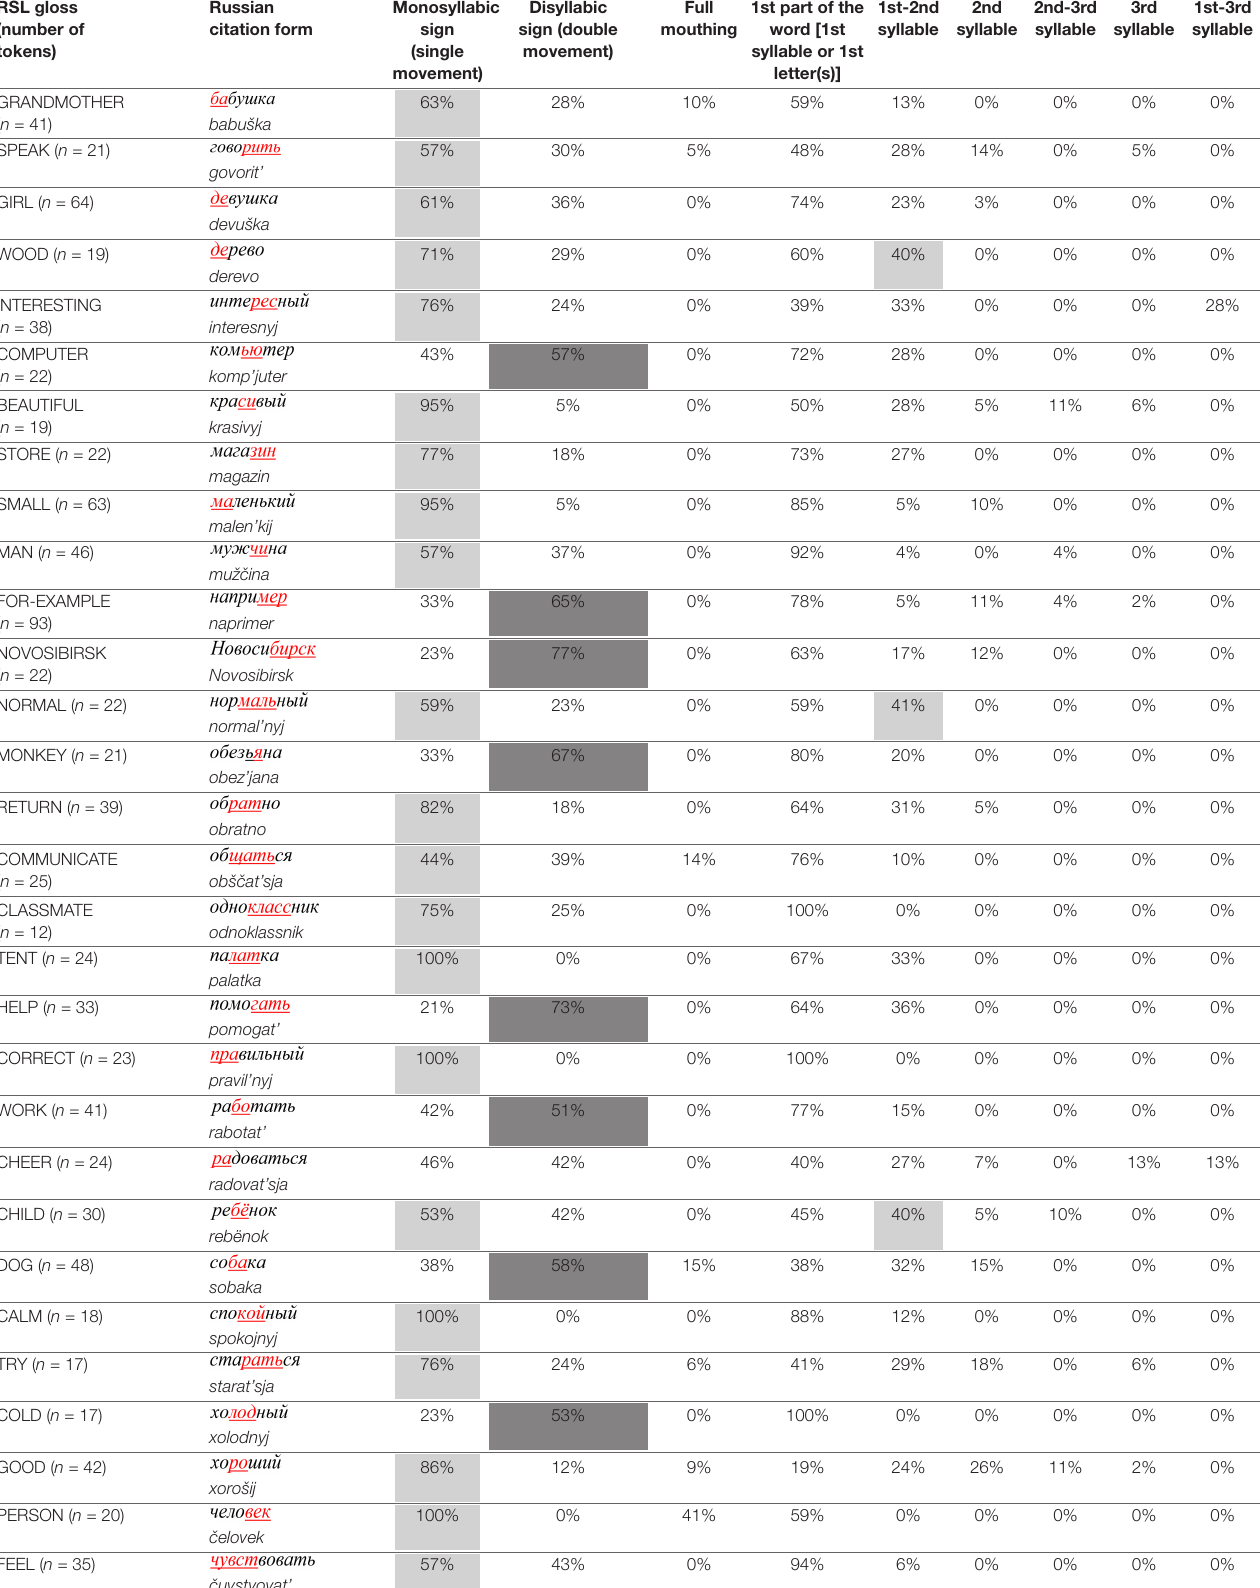
TABLE 2 | Thirty RSL signs showing their syllabic structure and the form of the co-occurring mouthings. RSL gloss (number